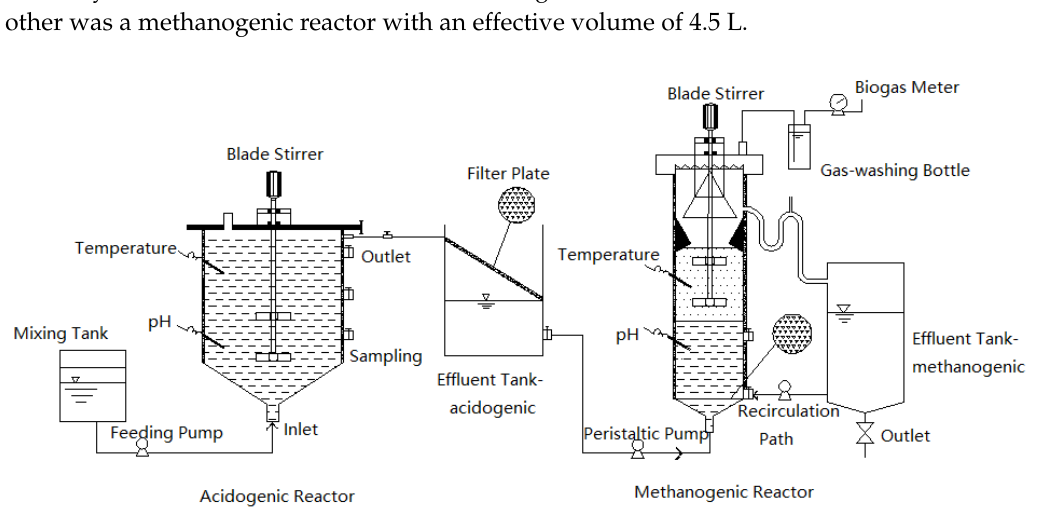
Figure 1. The configuration of the lab-scale two-phase anaerobic digestion reactor.